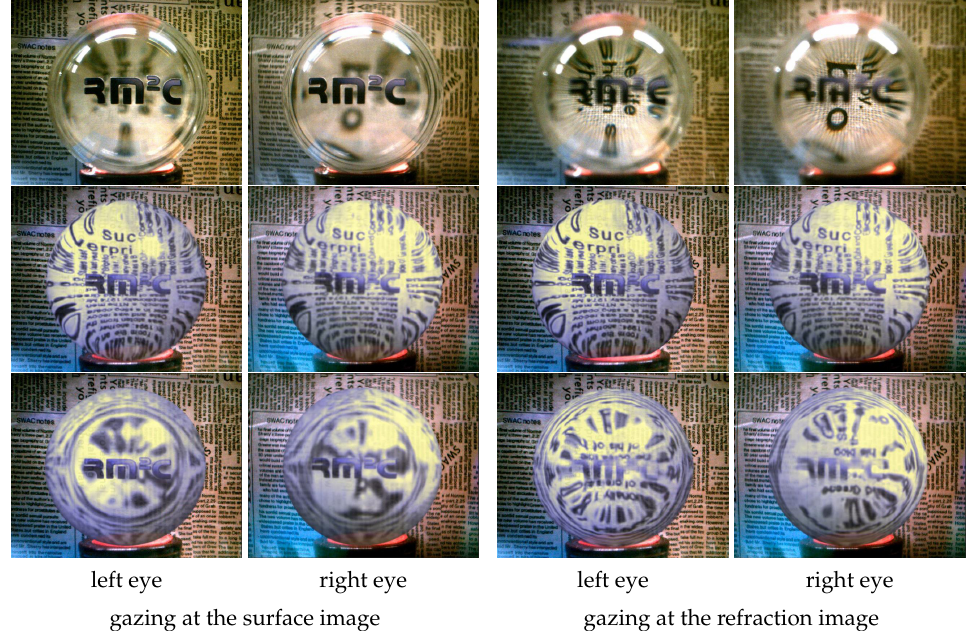
Figure 9. Visual effects of displayed transparent objects. ( Upper row ): real object. ( Middle row ): rendering using conventional method. ( Lower row ): rendering using our method.